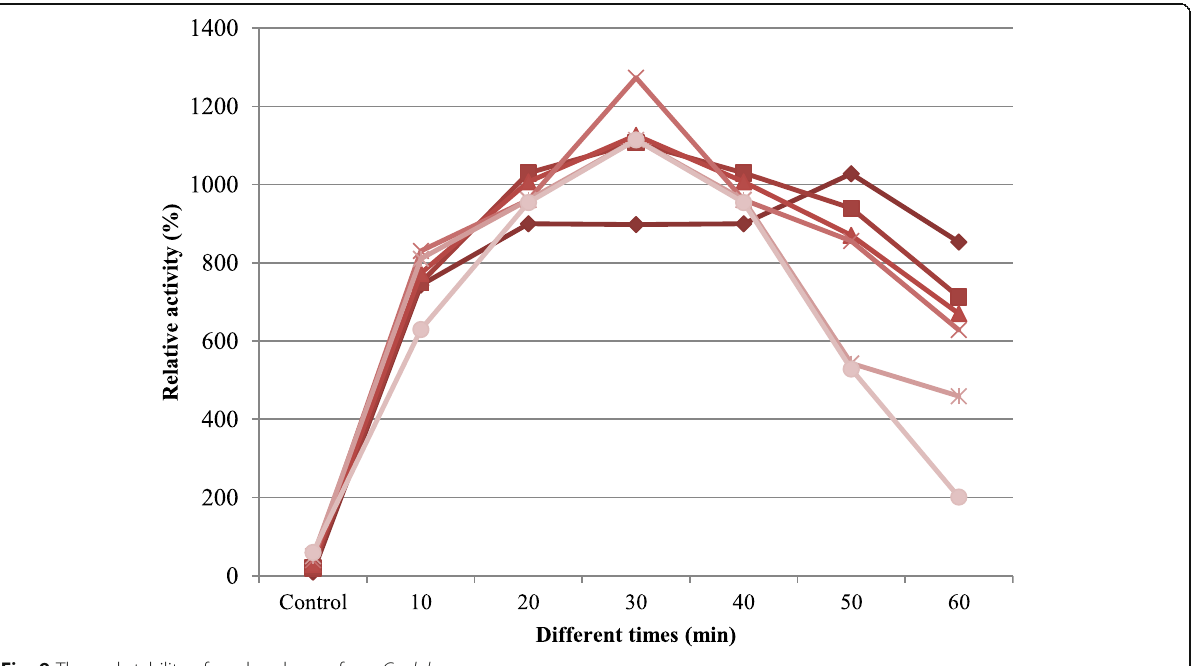
Fig. 9 Thermal stability of crude xylanase from C. globosum